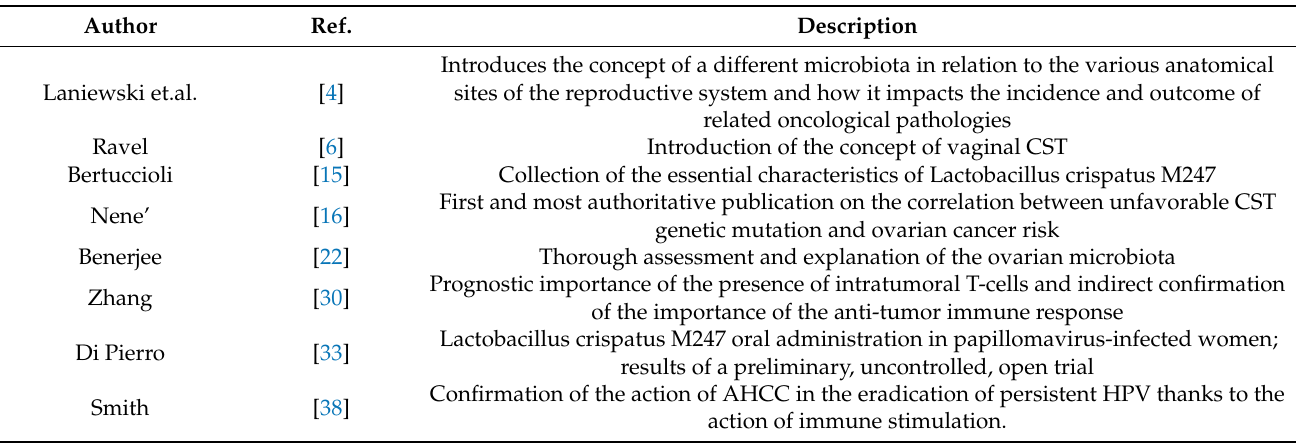
Table 2. Relevant research findings.